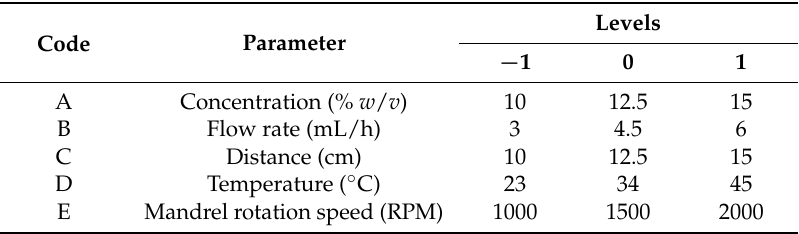
Table 1. Parameter settings for the experiment